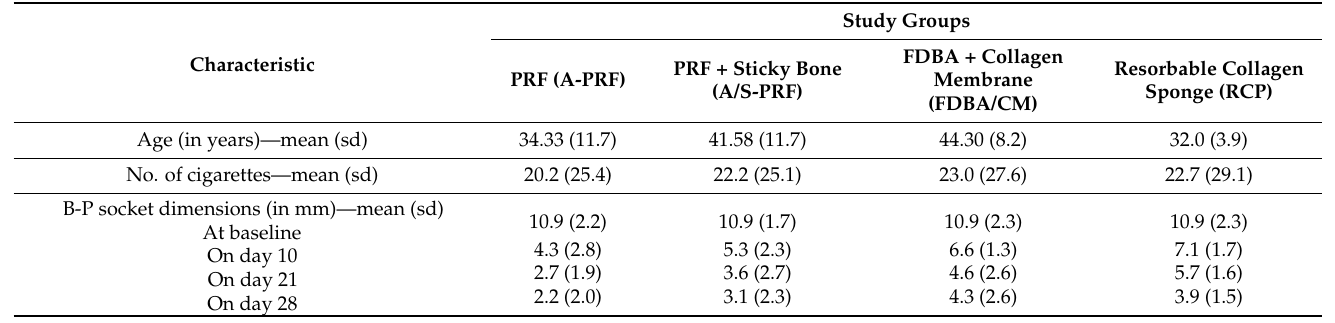
Table 1. Distribution of demographic and clinical characteristics of 4 study